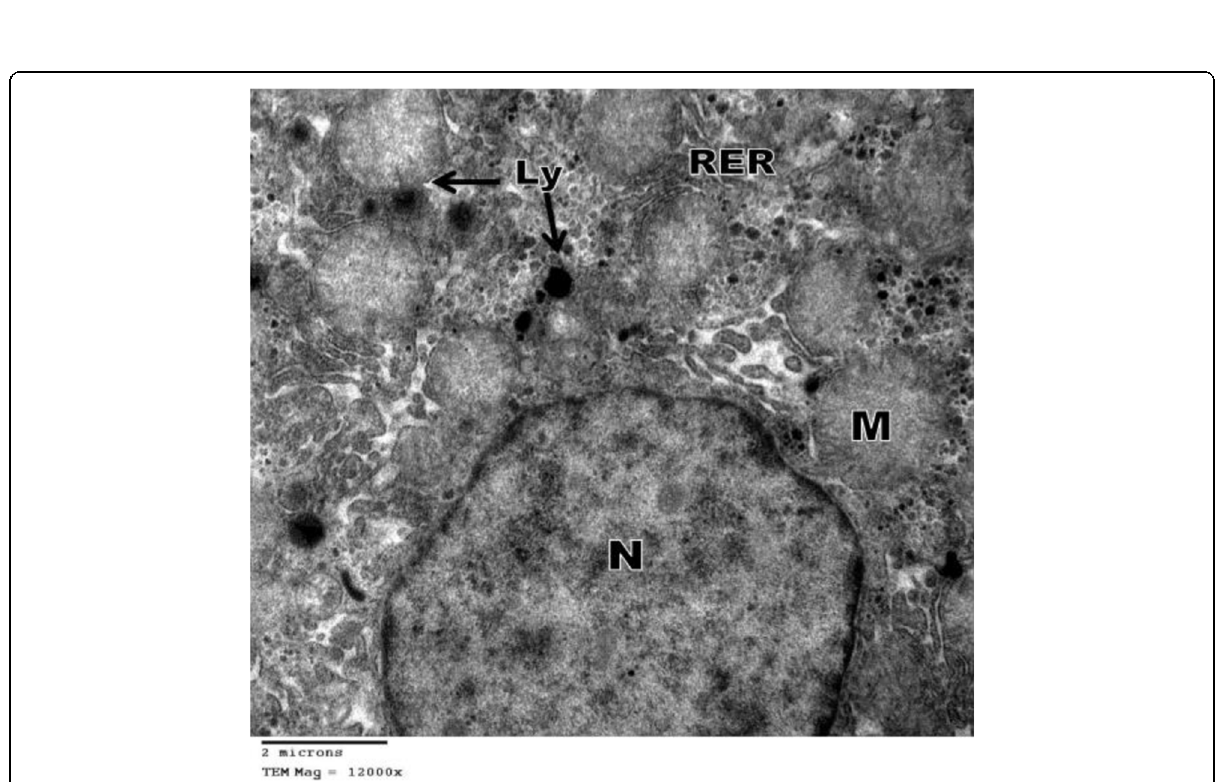
Fig. 14 An electron micrograph of a hepatocyte of treated mouse with Tamiflu (16 mg/kg b.wt.) for 5 days showing short stacks of rough endoplasmic reticulum (RER), swollen mitochondria (M), lysosomes (Ly), and part of the nucleus (N). (×